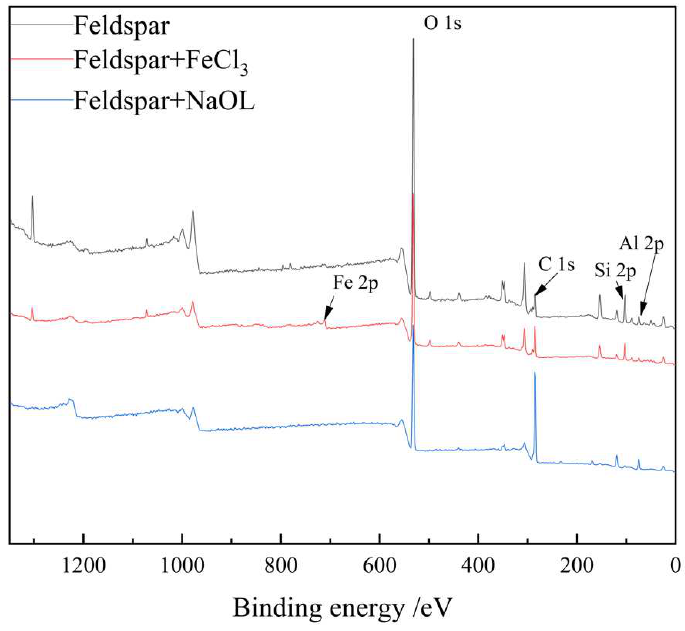
Figure 8. The XPS spectra of feldspar.